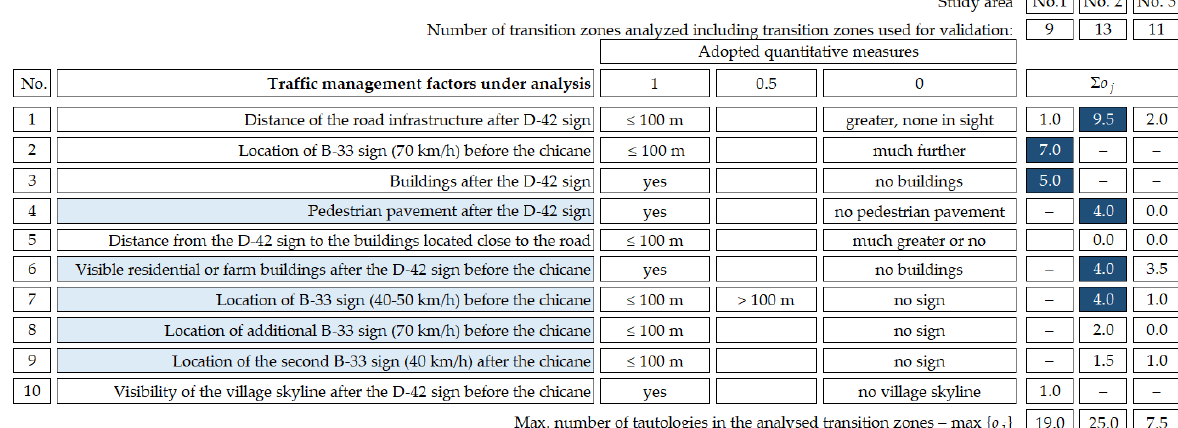
Figure 12. Comparison of initially adopted TM factors in the analysed study areas based on [26,27]. Legend: o j —number of confirmed logical tautologies in all the analysed transition zones in a given study area; (–) indicates that the factor was excluded from consideration in a given study area.